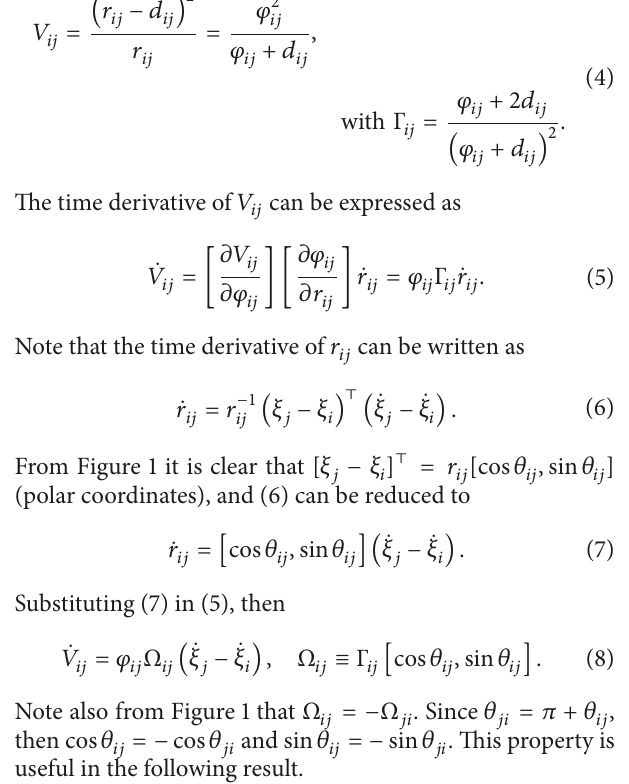
Figure 1: Relative distance and orientation among a pair of agents.